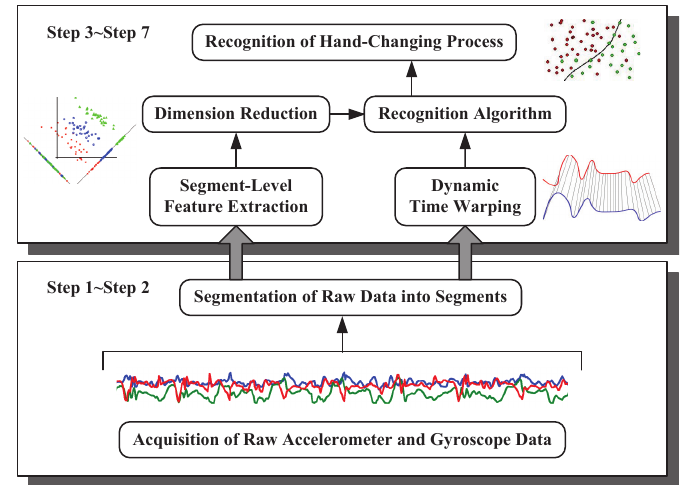
Figure 11. System overview of recognizing the hand-changing